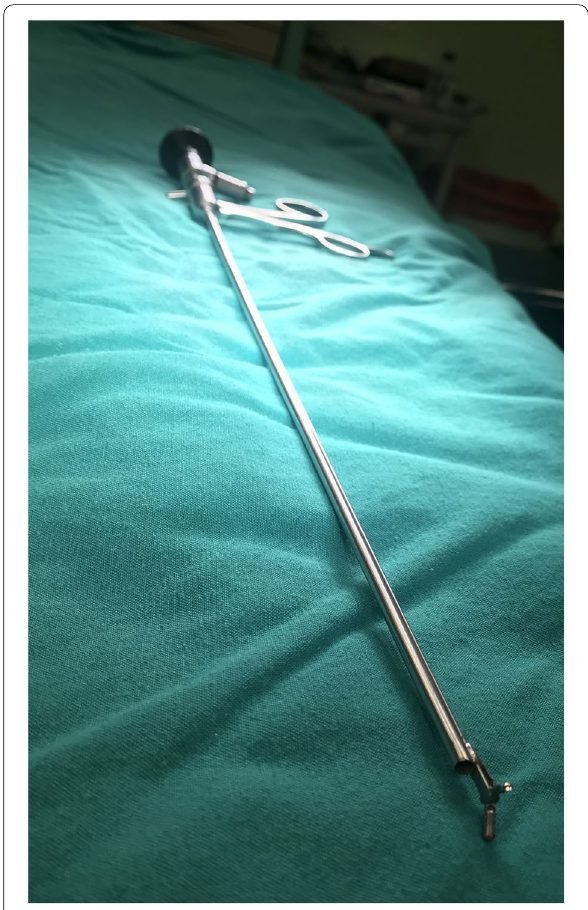
Fig. 2 Optical forceps used in the